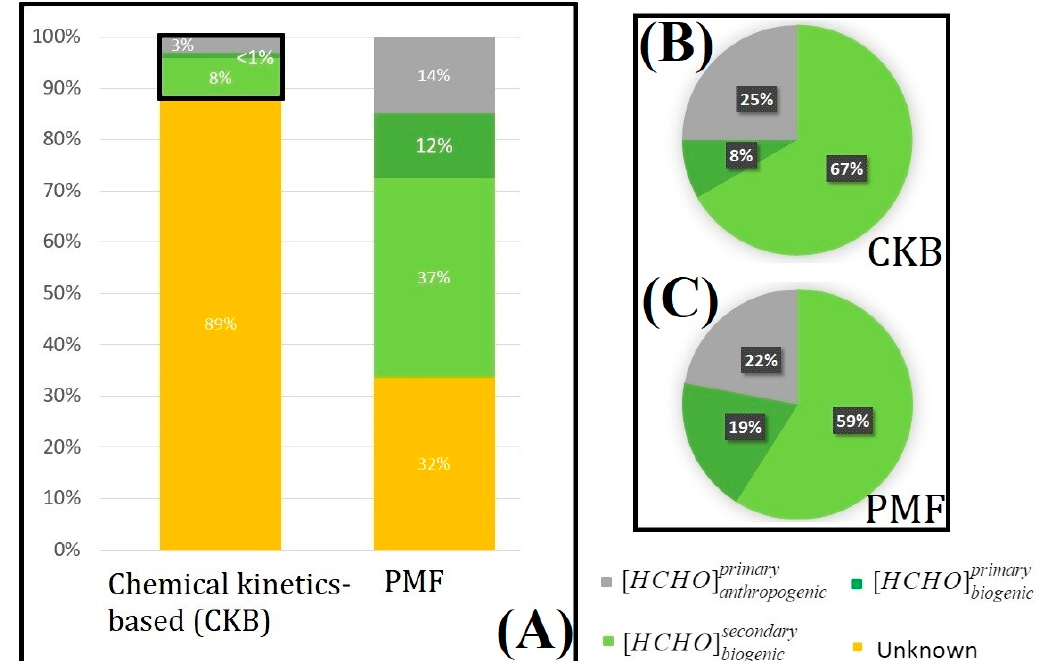
Figure 9. ( A ) Estimation of formaldehyde sources at the Maïdo site with CKB and PMF analysis. Percentages in pie chart format for the known part for ( B ) CKB and ( C ) PMF.